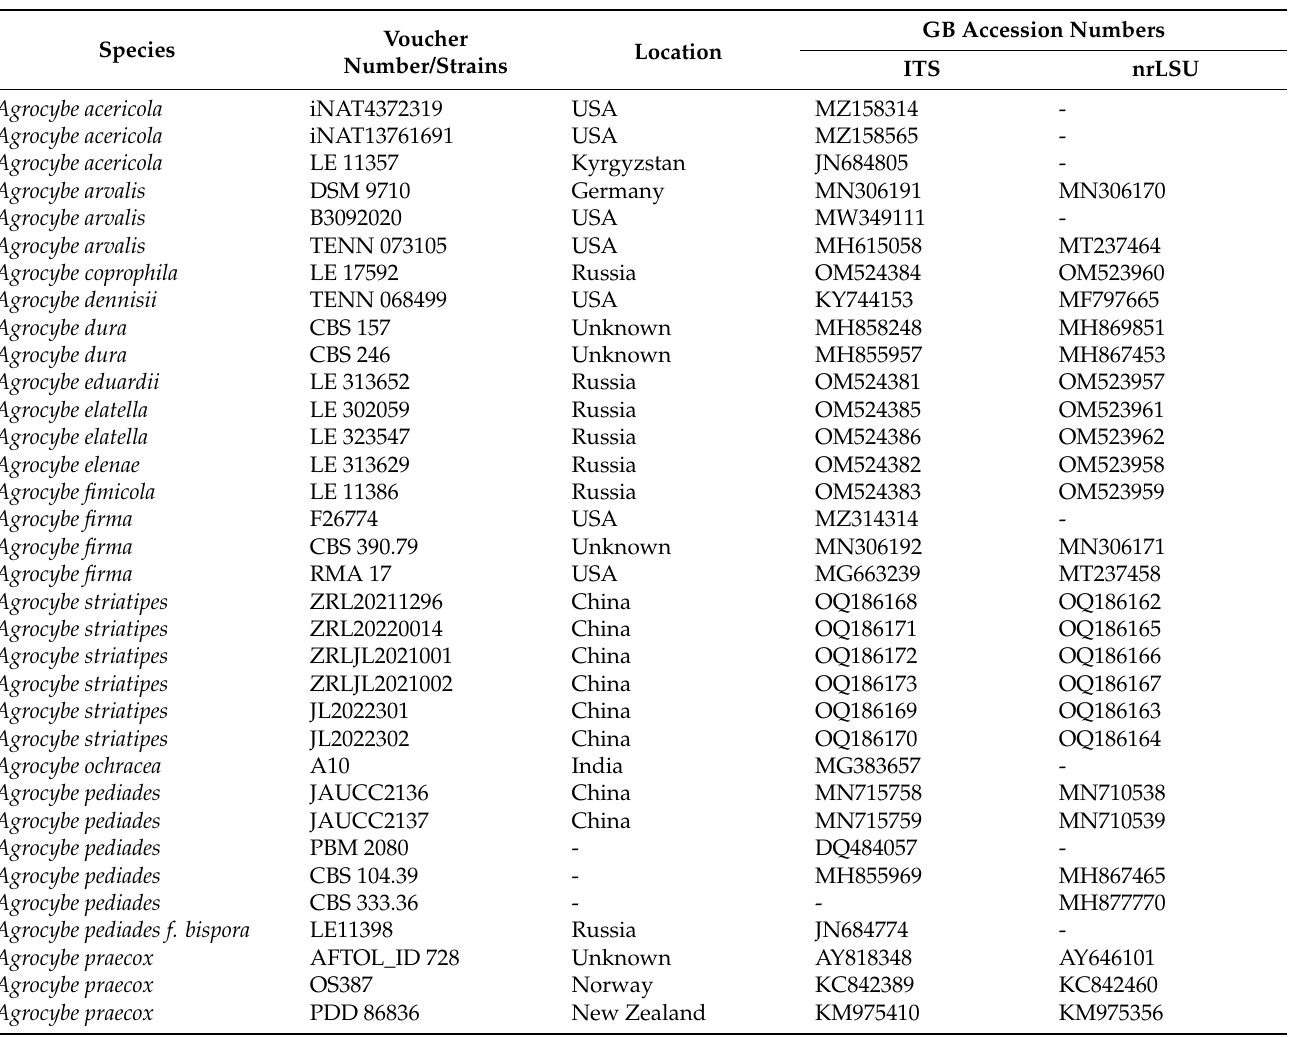
Table 1. Sequence information of Agrocybe used in molecular phylogenetic analyses; newly generated sequences are in red. Missing sequences are indicated by